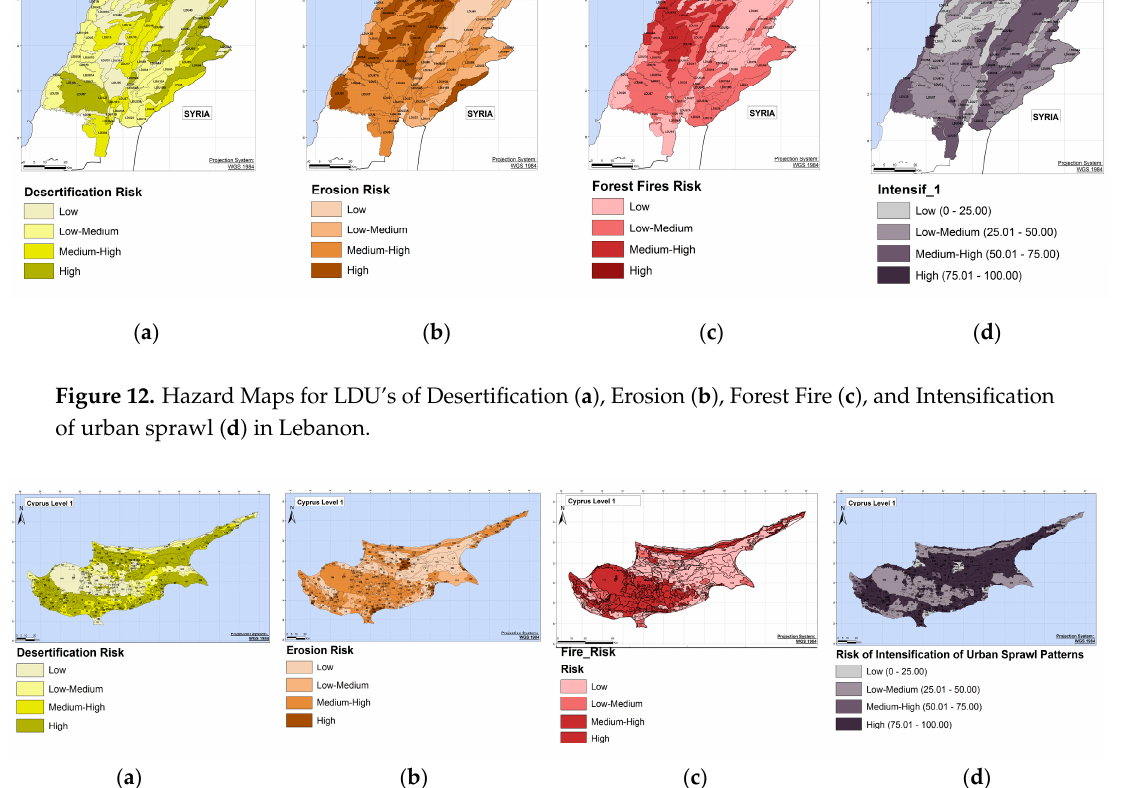
Figure 13. Hazard Maps for LDU’s of Desertification ( a ), Erosion ( b ), Forest Fire ( c ), and Intensification of urban sprawl ( d ) in Cyprus.